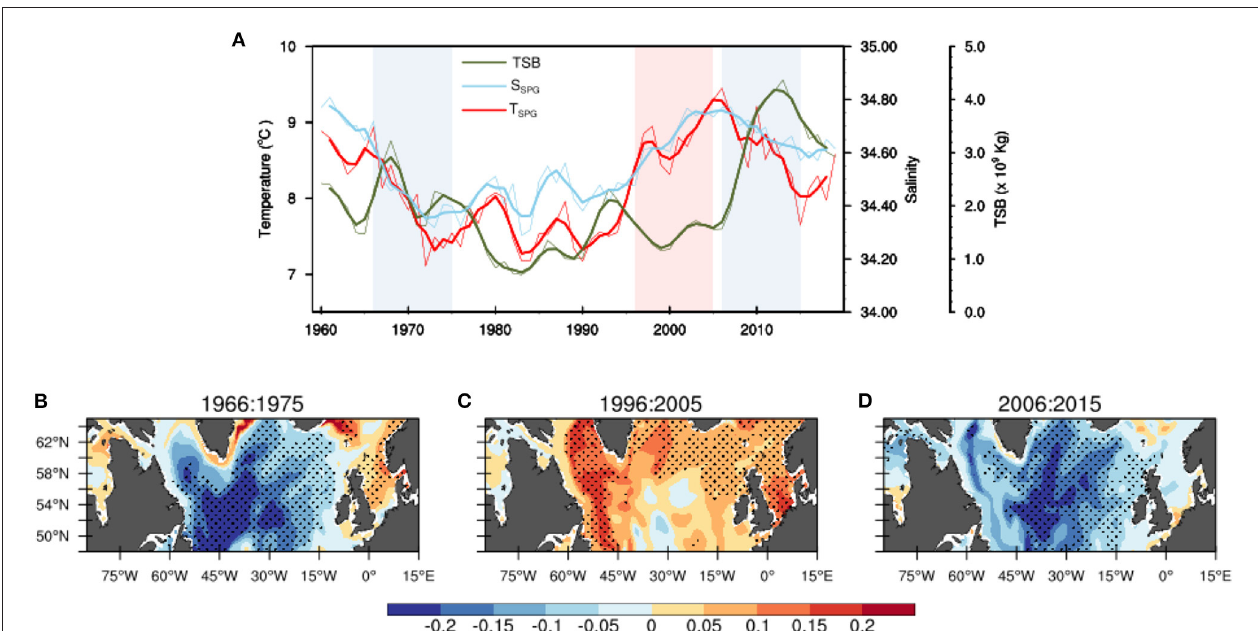
FIGURE 2 | (A) . Time series of modelled surface temperature and surface salinity of the North Atlantic Subpolar Gyre (-60:-10 ◦ E, 50:62 ◦ N) from the assimilation experiment, and total stock biomass of cod in the Barents Sea for the period 1960–2019. For each of the time series shown, light lines are annual means and bold lines are three-year running mean values. The time series are not linearly detrended. The blue and red shaded time periods highlight the three dominant decadal trends. Trends in the surface temperature of the North Atlantic Subpolar Gyre ( o C yr − 1 ) for (B) 1966–1975 cooling, (C) 1996–2005 warming, and (D) 2006–2015 cooling. The stippling marks statistically significant trends at 90% confidence level.